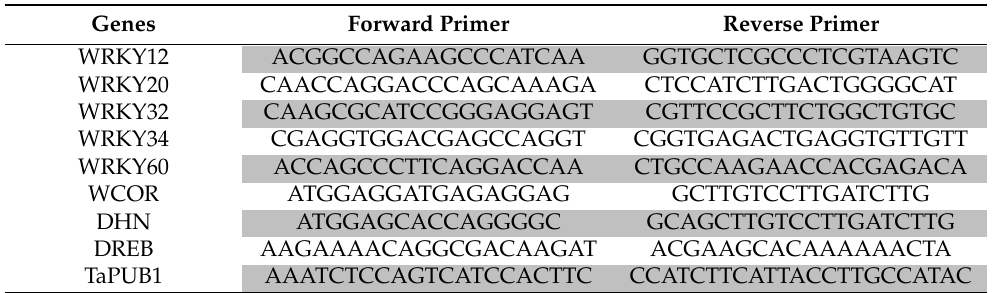
Table 3. Primers sequences designed for quantitative real time PCR analysis of genes in wheat.